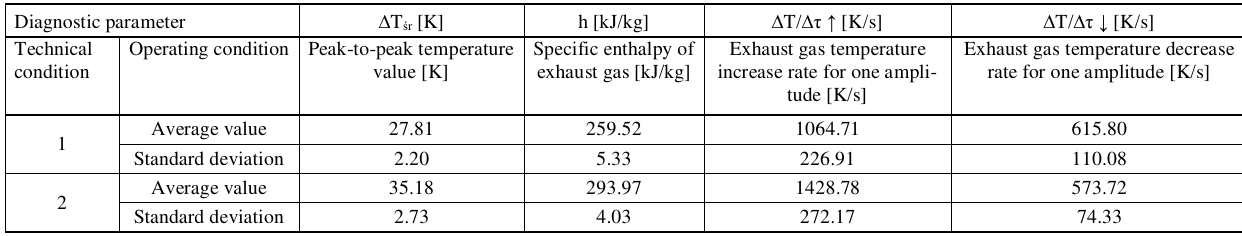
Fig. 8. Values of diagnostic parameters such as specific enthalpy and peak- to-peak exhaust gas temperature within one engine cycle, depending on the Table 2. Summary of determined values of diagnostic parameters with their standard